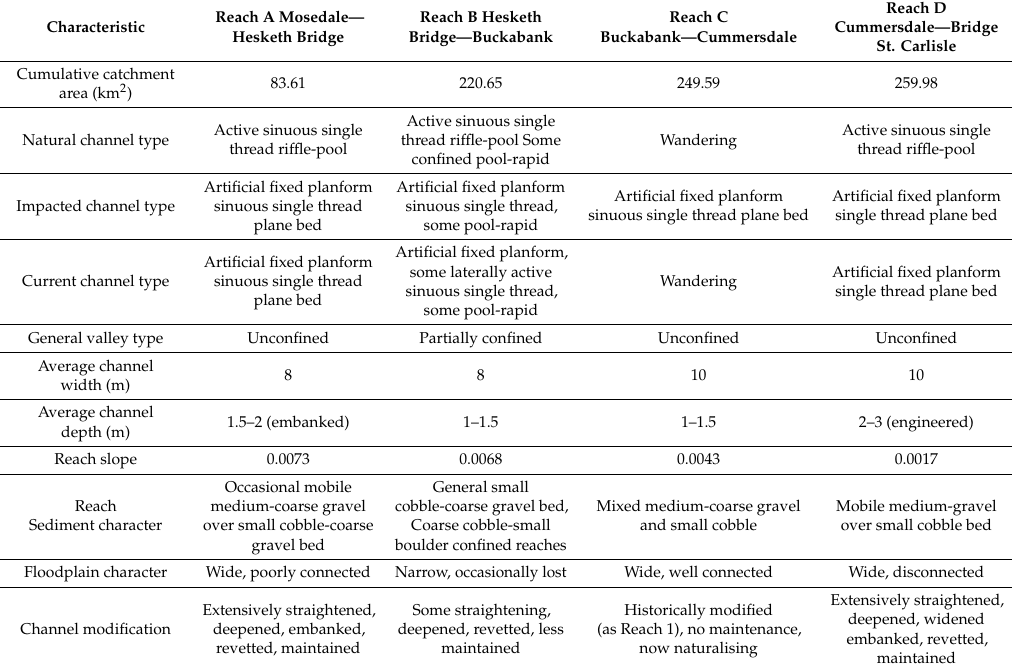
Table 1. Character of the 4 reaches of the River Caldew in the study